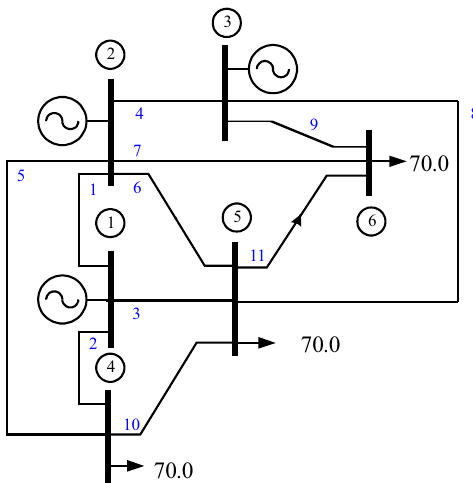
Figure 1. Test system I: 6-bus power system (Wood and Wollenberg [6]).